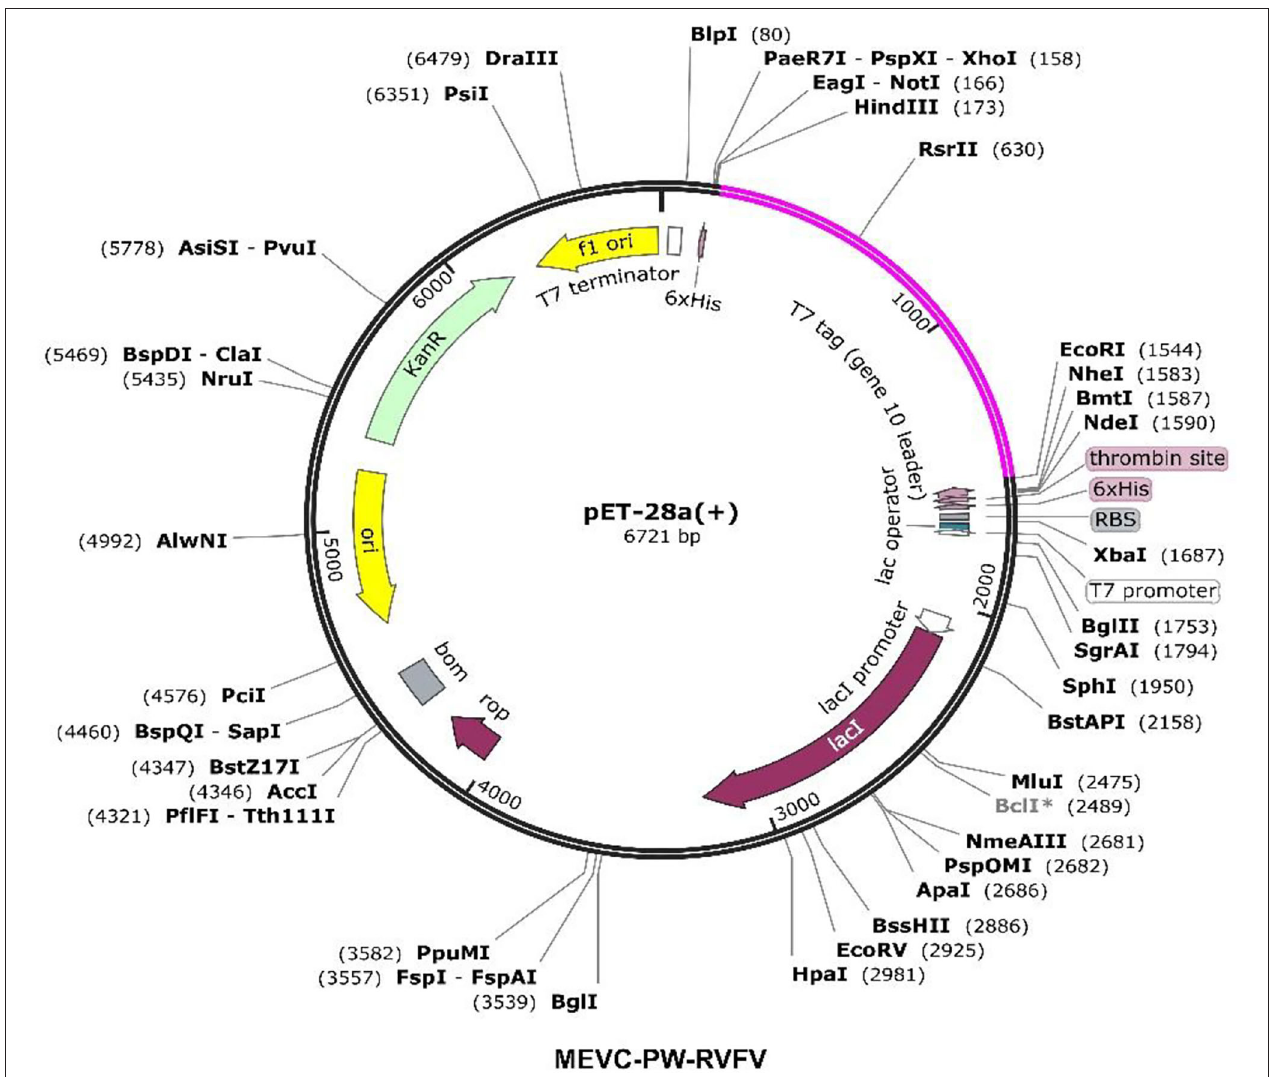
FIGURE 5 | Constructed plasmid maps with pink-colored inserts for the designed MEVC against the whole proteome of